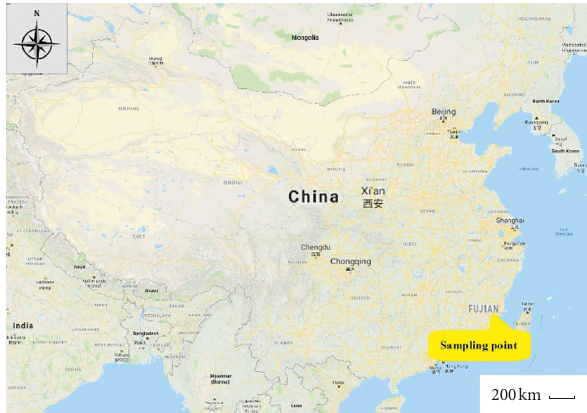
Figure 1: Location of outcrop from which tonalite samples were